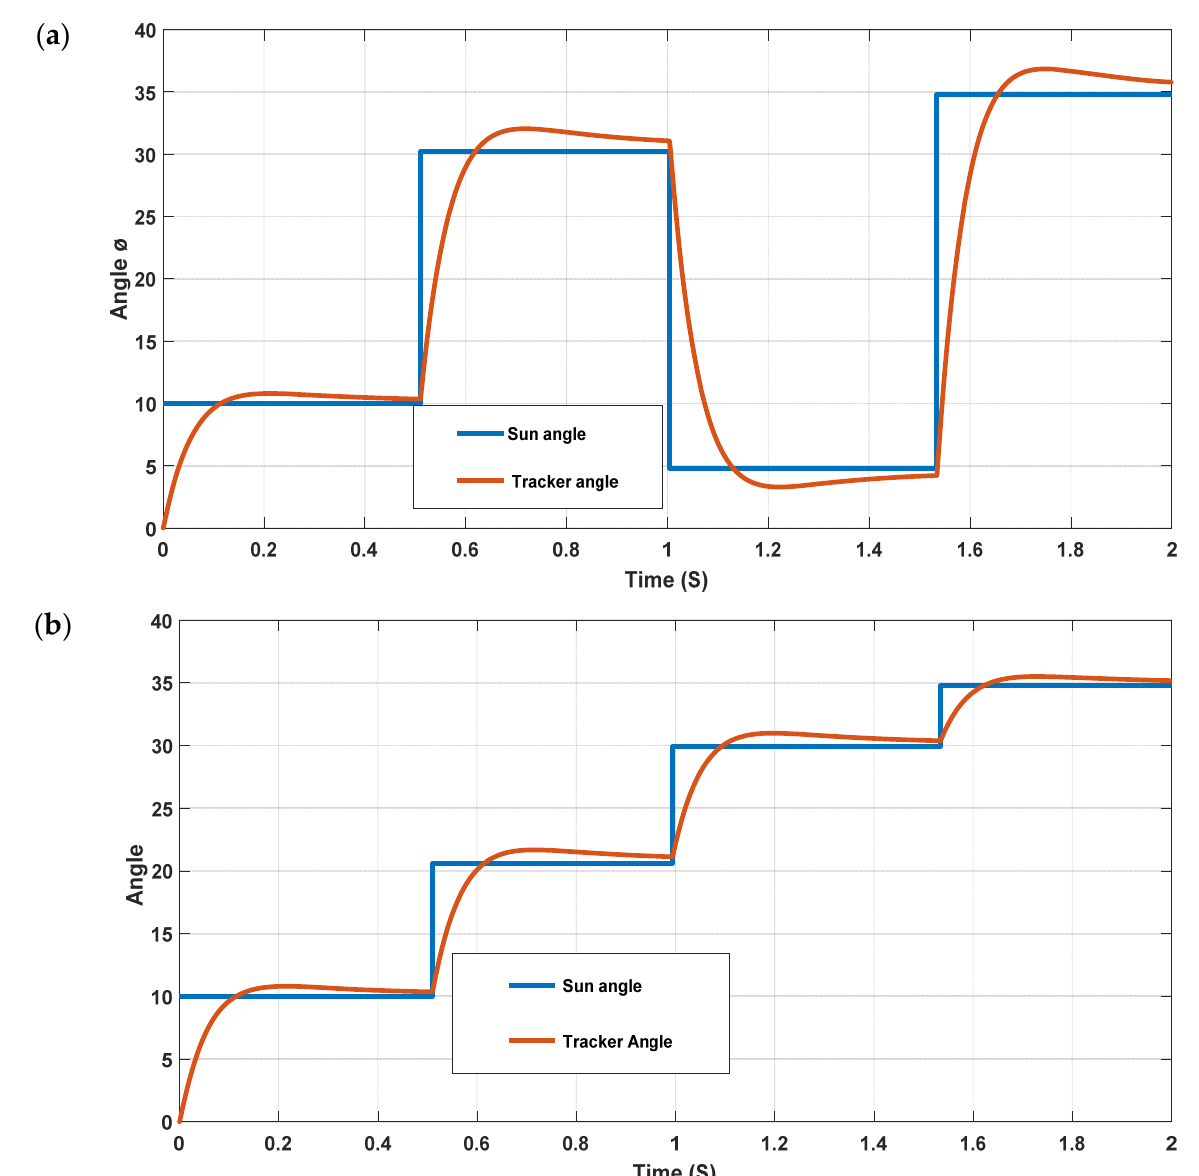
Figure 14. Variation of the motor angle with respect to the sun’s angle: ( a ) for test 1. ( b ): for test 2. Several studies have analyzed the efficiency of energy production using single-axis trackers compared to fixed panels [35–38]. BAHRAMI et al. [37] determined that the increase in solar production of a PV plant with single-axis trackers compared to a fixed- panel system is around 17.22–31.23% [39–41]. That fluctuation in energy production can be reduced depending on the tracker distribution in the PV plant [42–44]. To validate our design, we compared the motor angle and the sun angle over an entire day if the panel is fixed and if the panel is attached to our prototype single-axis tracker. As the sun begins to shine at 5:00 a.m., our system records data until sunset. Figure 15 shows that the solar tracker device maximizes the sun’s irradiance by keeping the solar module’s active surface vertical at the sun’s angle. From noon until sunset, we find that the fixed panel loses a large amount of solar radiation during the